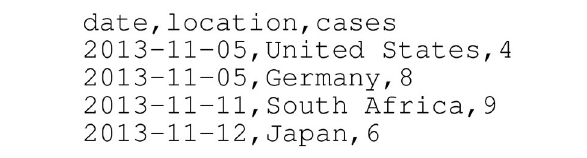
FIGURE 3 | Sample epidemiological case count data in CSV format. CSV files are plain text files that allow tabular data to be laid out as rows separated by newlines and columns separated by commas. This time series does not contain real data and only exists for demonstration purposes.